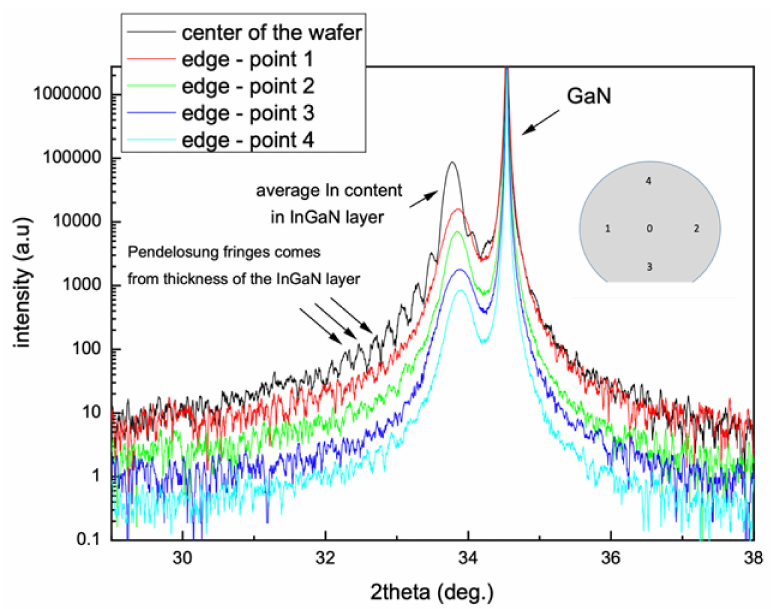
Figure 1. Results of the XRD (X-ray diffraction) measurements for 5 different points on a sample processed at a pressure of more than 2 bar.